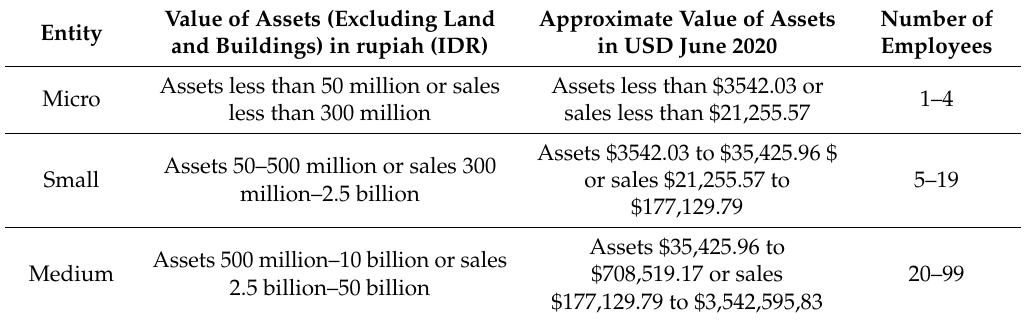
Table 1. The characteristics of Indonesian micro, small, and medium enterprises (SMEs). Value of Assets (Excluding Land Entity and Buildings) in rupiah